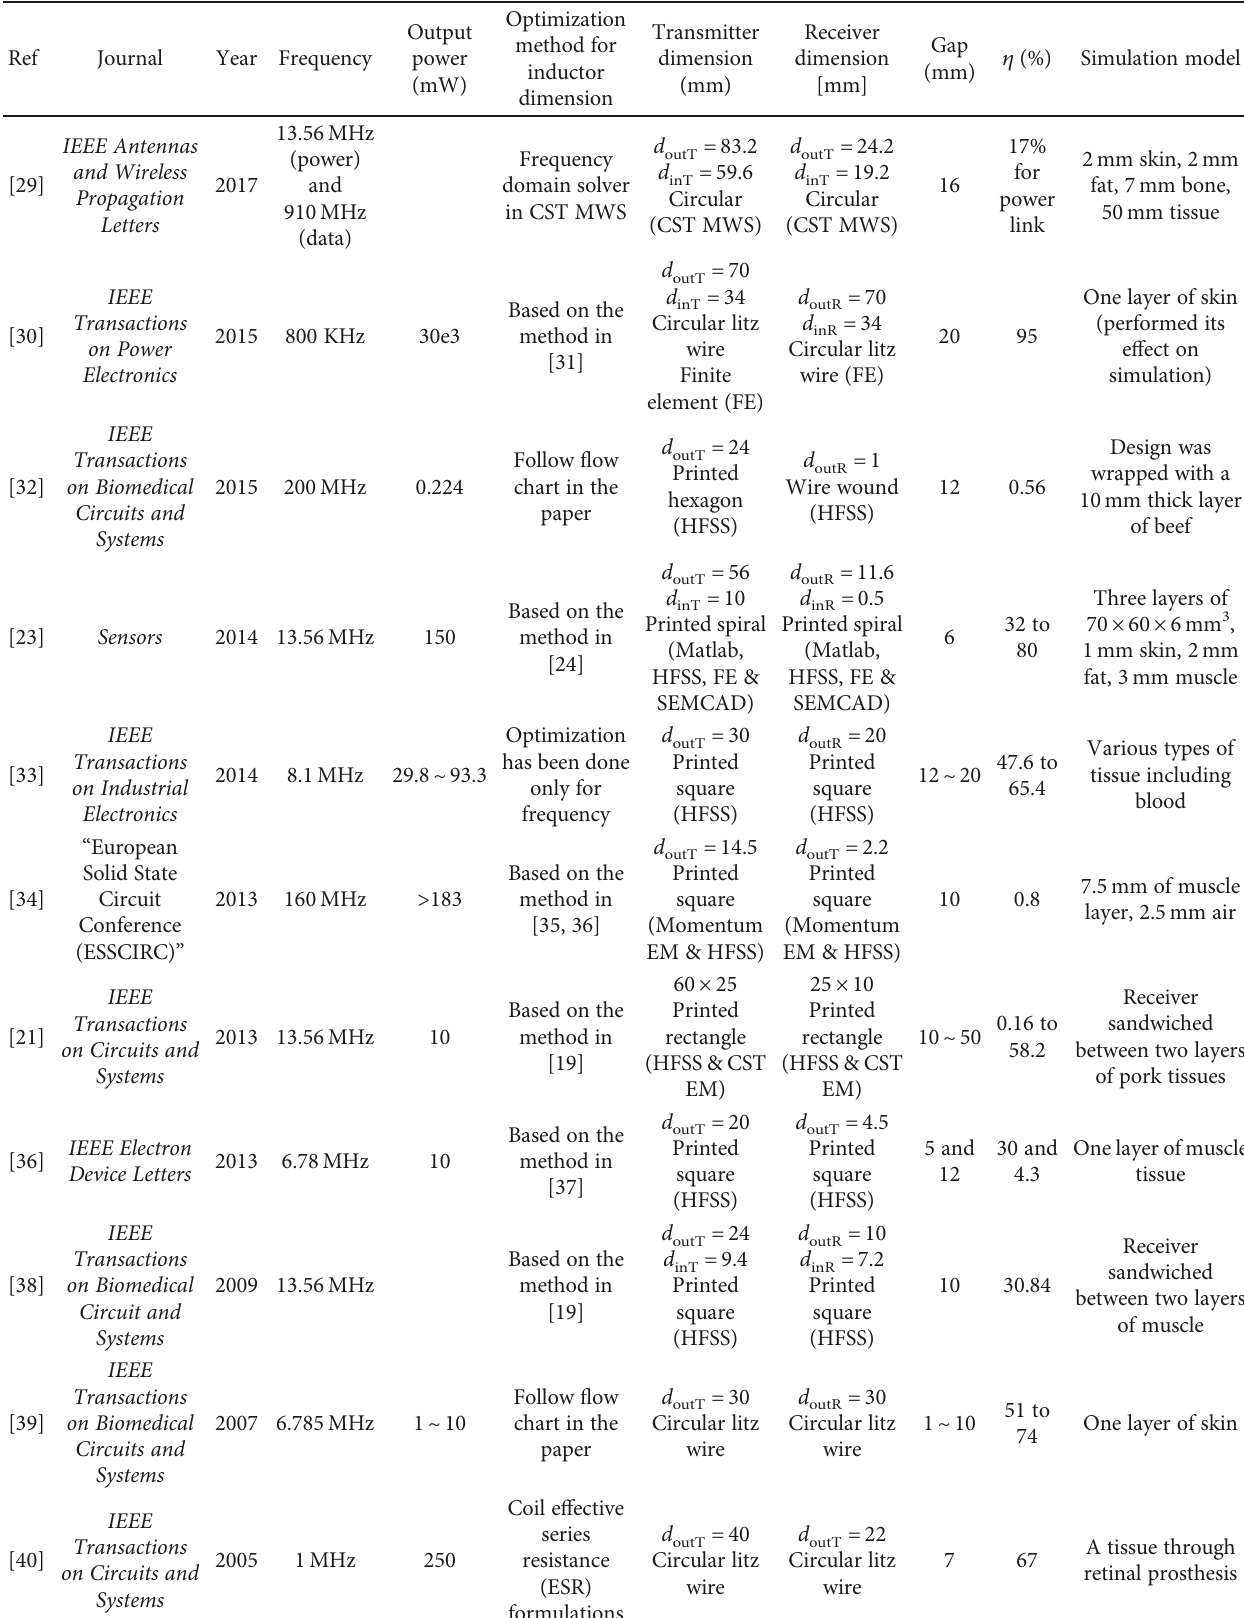
Table 2: Implantable power device modeled in